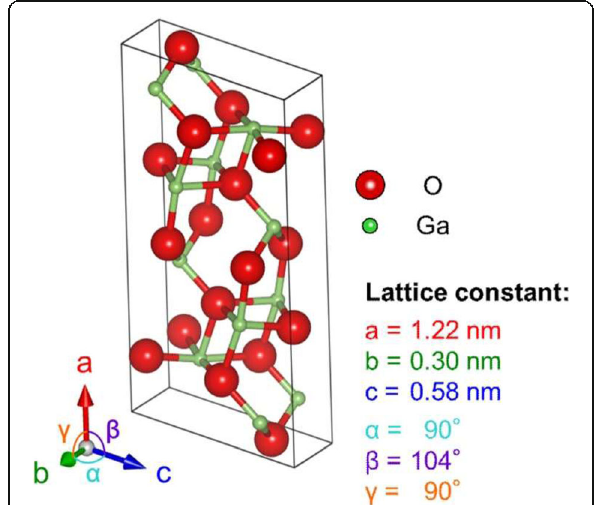
Fig. 2 The lattice structure of β -Ga 2 O 3 crystal. Reprinted from ref. [5]